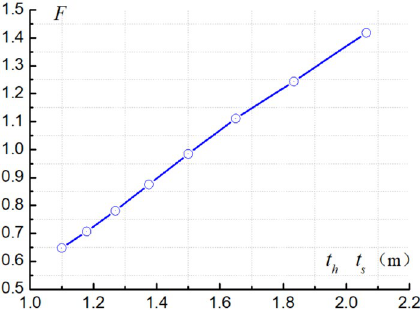
Figure 13. Curves for the thickness of rock strata vs the safety factor of the slope.